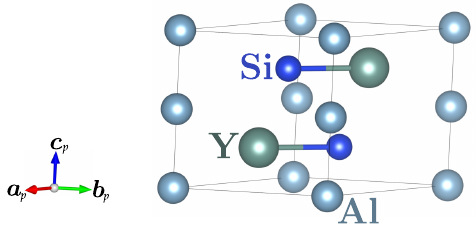
Figure 1. Primitive cells of YAlSi with orthorhombic Cmcm